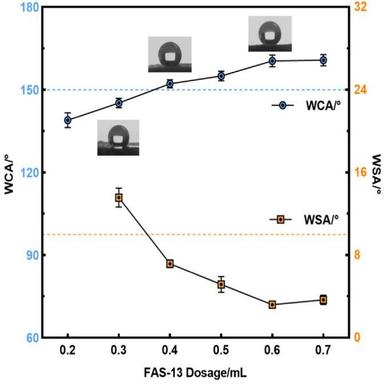
Relationship between the dosage of FAS-13 and CA/SA of the sample surface.